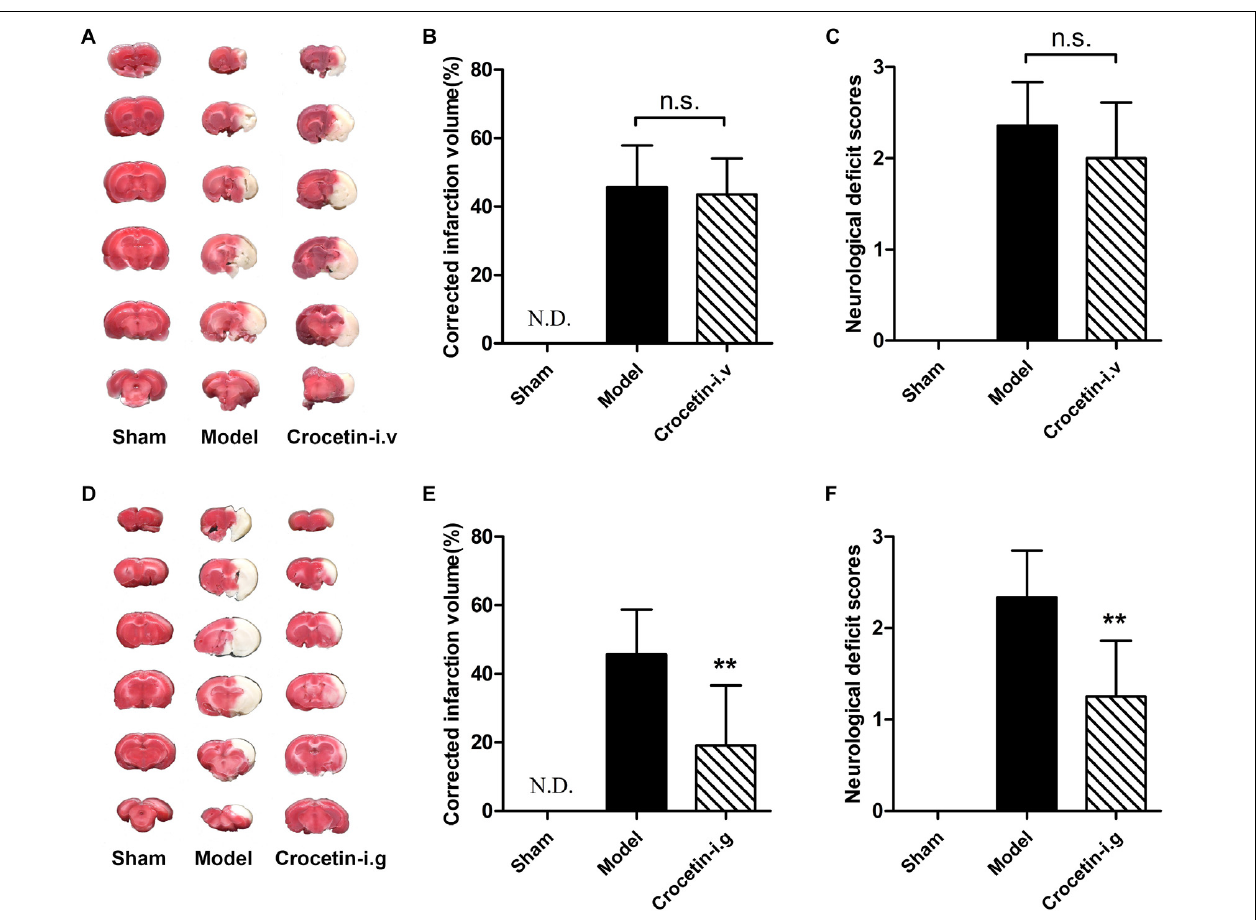
FIGURE 4 | The effect of crocetin on cerebral I/R injury. Crocetin was treated at equal molar dose to crocin (0.33 mg/kg for intravenous administration and 20 mg/kg for oral administration). Representative images of the same brain stained with TTC (A) , average infarction volumes corrected for brain edema as indicated (B) and the neurological deficit scores in each group (C) are shown after the intravenous administration of crocetin. Data are represented as the mean ± SD ( n = 6), N.D., infarction not detected. Representative images of the same brain stained with TTC (D) , average infarction volumes corrected for brain edema as indicated (E) and neurological deficit scores for each group (F) are shown after the oral administration of crocetin. Data are presented as the mean ± SD ( n = 6), N.D., infarction not detected. ∗∗ P < 0.01 vs. model